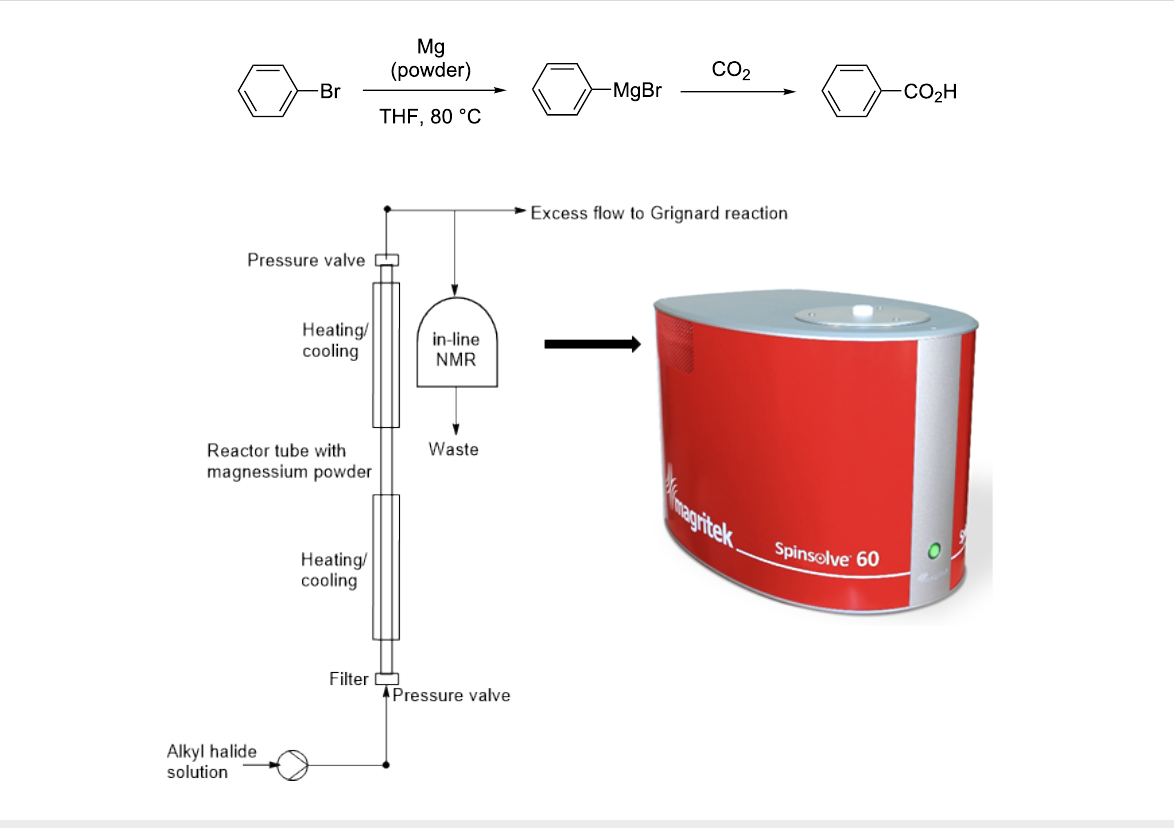
Figure 5: Scheme and experimental setup of the flow